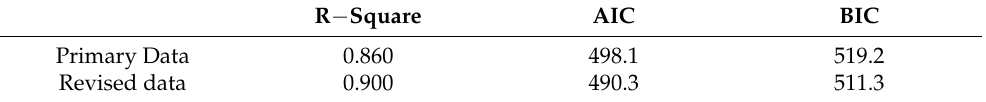
Figure 6. OLS was used for regression analysis: ( a ) OLS was used for regression analysis of 103 original data. ( b ) After the 82nd abnormal sample was removed, 102 data were regression-analyzed by OLS. Table 6. The changes of R − Square, AIC and BIC before and after the removal of outliers were com- pared.